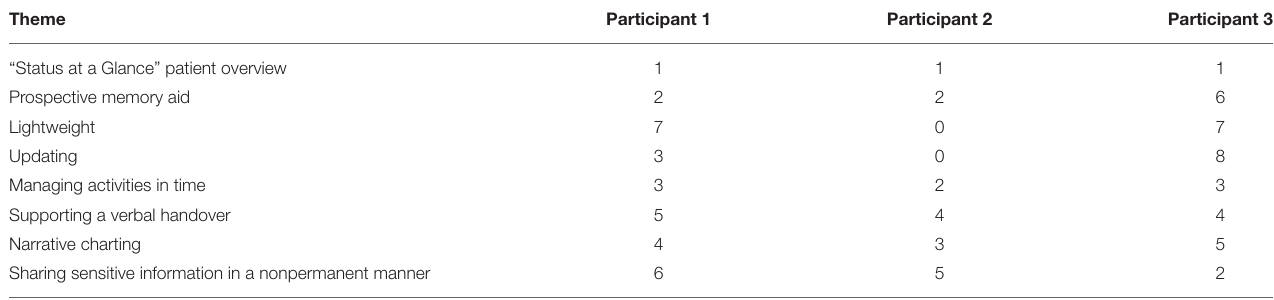
TABLE 4 | Rankings of relevance of findings for